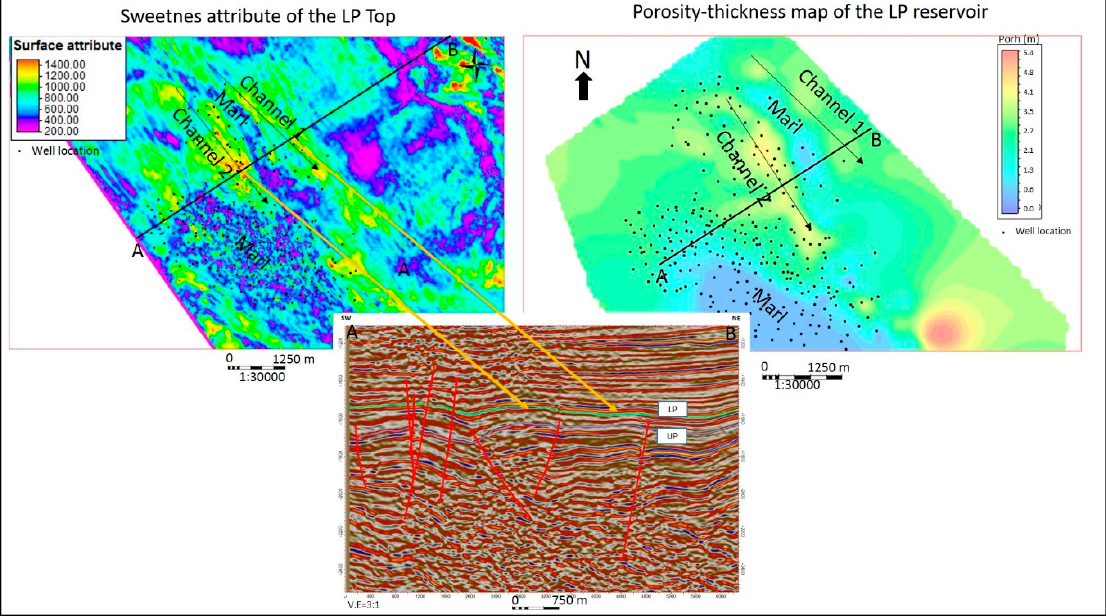
Figure 12. Comparison of the sweetness attribute and porosity–thickness map of the “LP” reservoir [29].